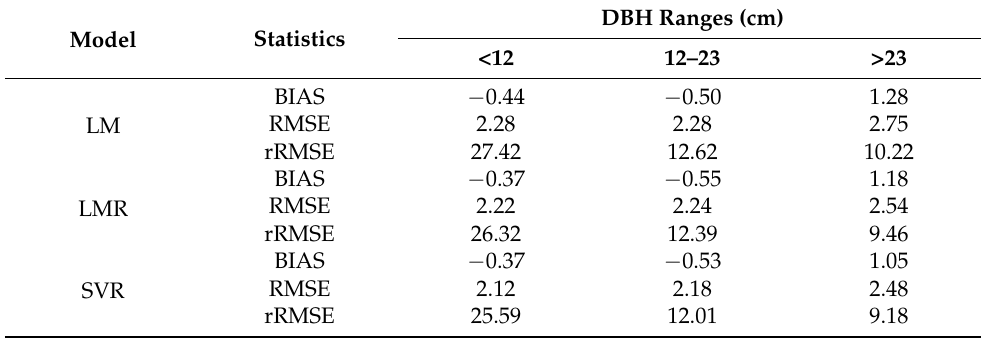
Table 7. Summary of accuracy assessment results for the validation dataset for different DBH ranges. Positive bias indicates